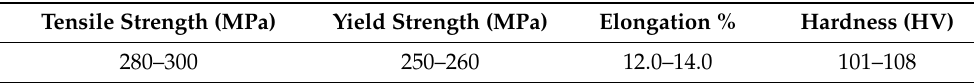
Table 2. Mechanical properties of aluminium 6061-T6 [55].